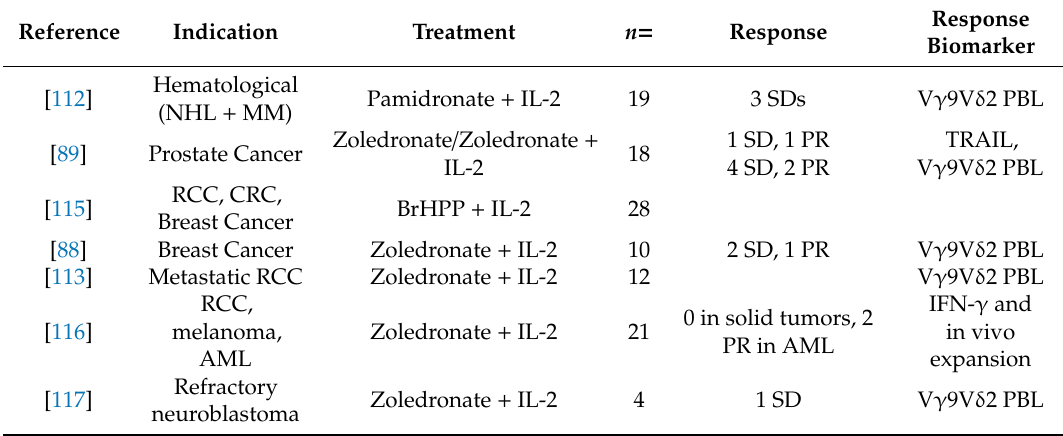
Table 2. Completed Phase I clinical trials with in vivo stimulation of gamma delta T cells. RCC: